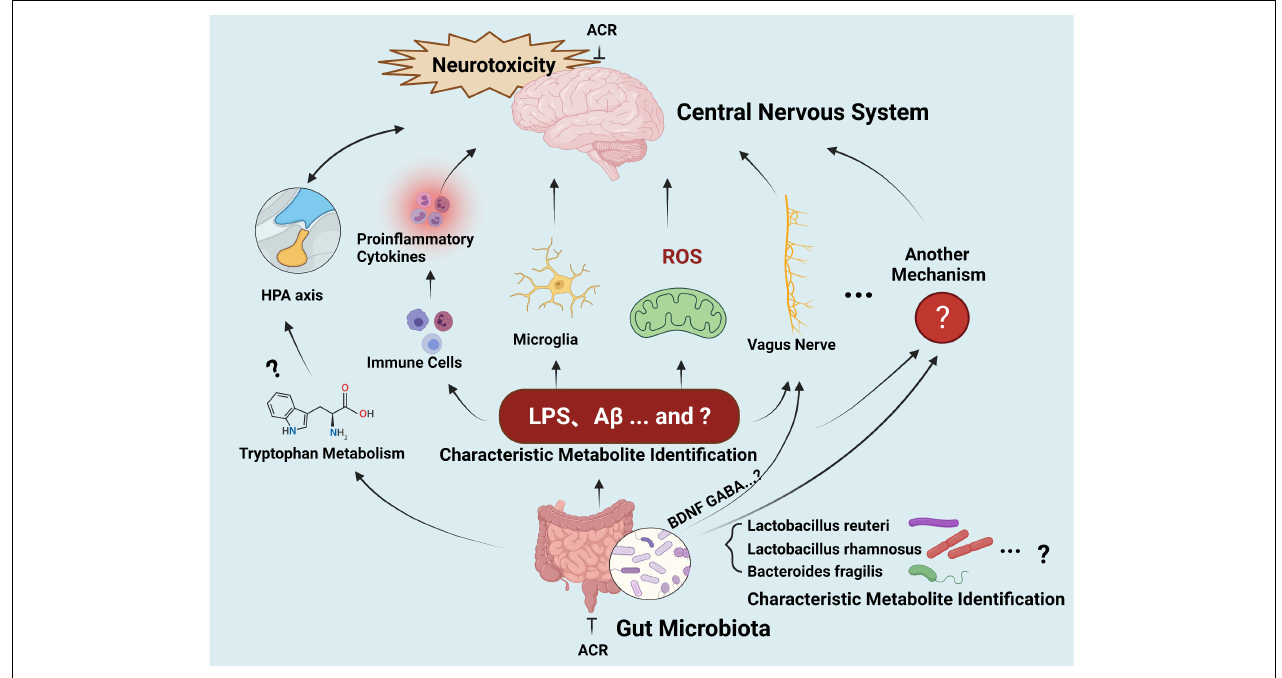
FIGURE 5 | The gut-brain axis in ACR-induced